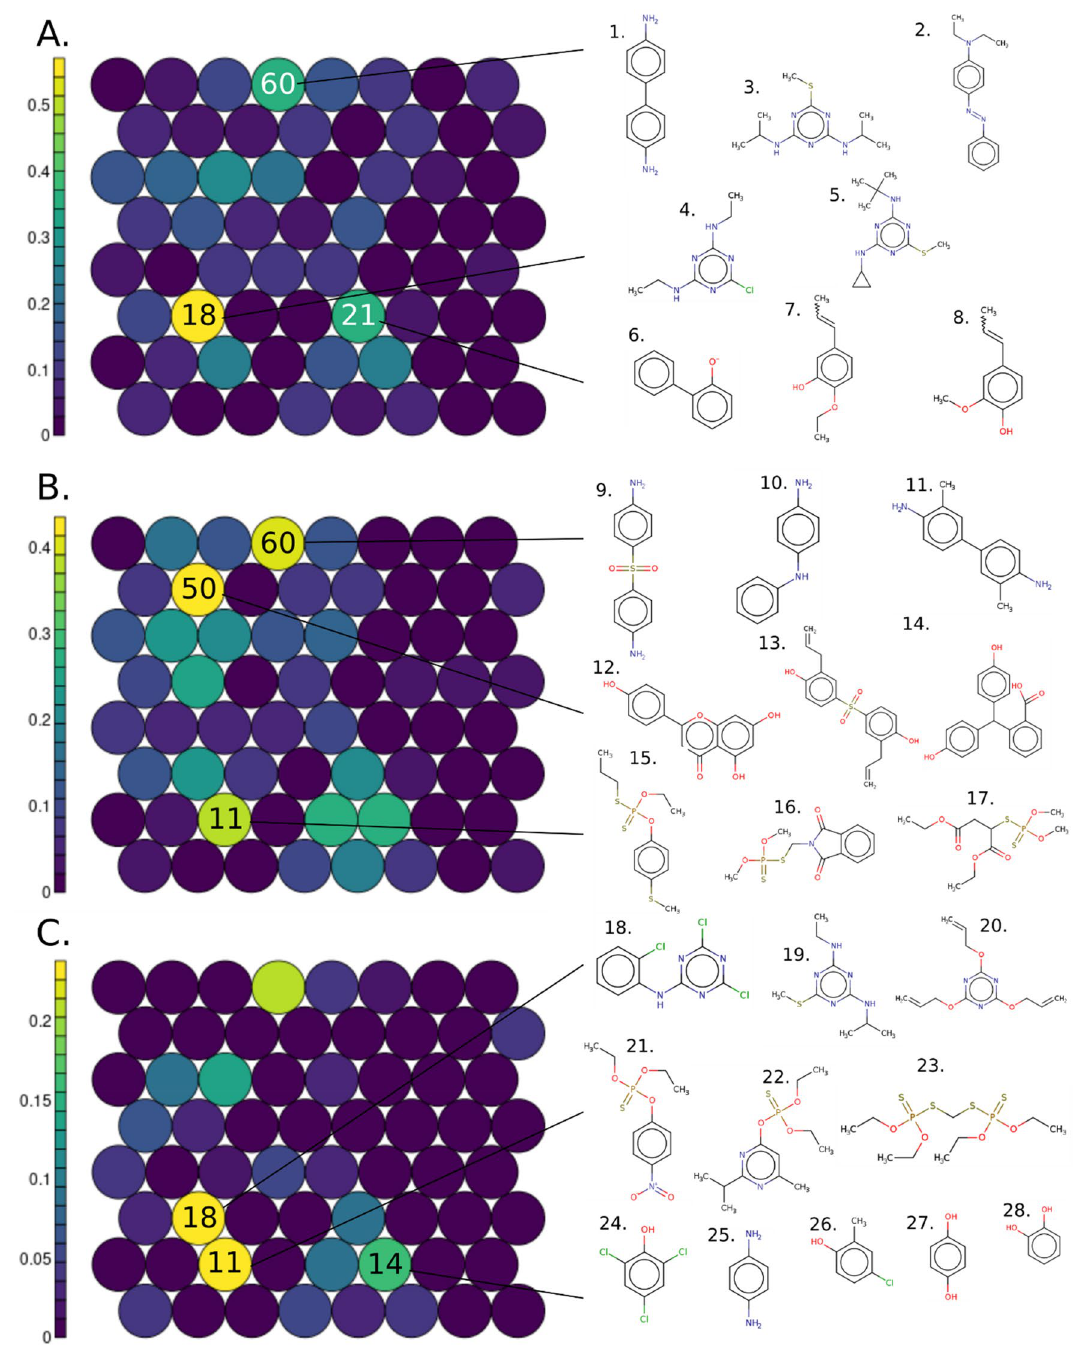
Figure 3. Structure based SOM on the 1,925 curated structures tested on the H295R assays including 64 clusters colored ( A ) using the percent of E2up chemicals, 182 structures, ( B ) using the percent of P4up chemicals, 186 chemicals and ( C ) the percent of the union of E2up and P4up structures, 71 structures. Some structural examples for enriched clusters are shown; cluster 60: 1. benzidine (92–87–5), 2. C.I. Solvent Yellow 56 (2481–94–9); cluster 18: 3. Prometryn (7287–19–6), 4. Simazine (122–34–9), 5. Cybutryne (28,159–98–0); cluster 21: 6. sodium 2-phenylphenate tetrahydrate (6152–33–6), 7. 2-ethoxy-5-(1-propenyl)phenol